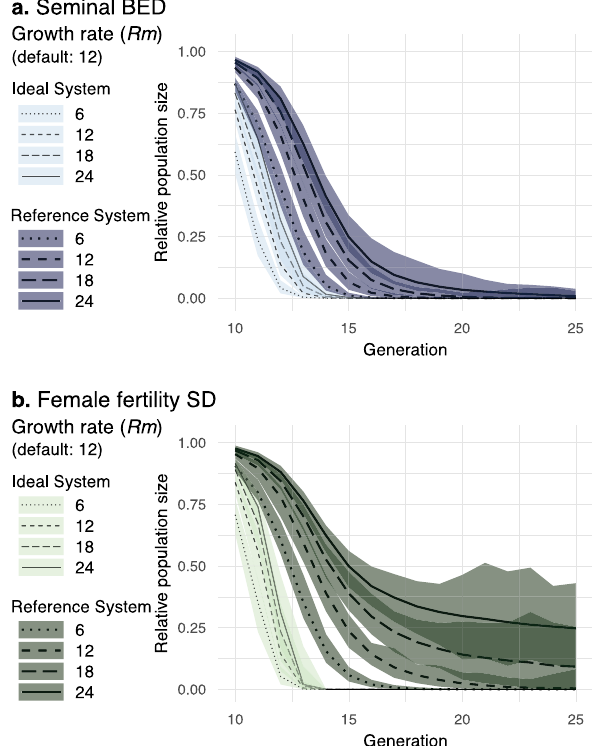
Figure 5. Impact of low-density growth rate. Relative population size from generation 10 to 25 is shown with ideal and reference drive parameters for sBED ( a ) and ffSD ( b ) using in each case different values of Rm . Rm was adjusted with the Fecundity parameter. Lines represent the 100-simulations mean value while the colored envelopes stand for the maximum and minimum